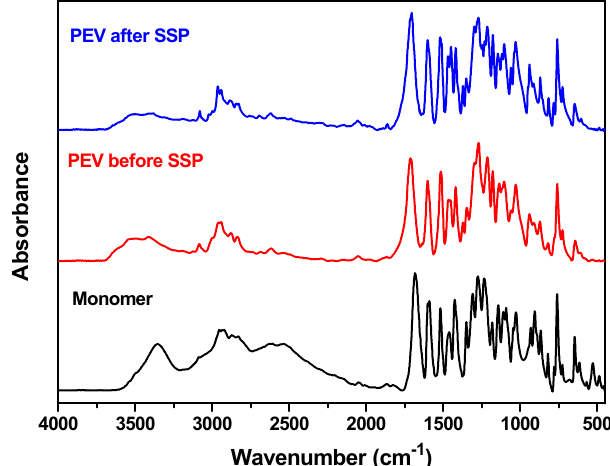
Figure 1. FT-IR spectra of 4-(2-hydroxyethoxy)-3-methoxybenzoic acid and the obtained polymers, before and after solid state polymerization (SSP).